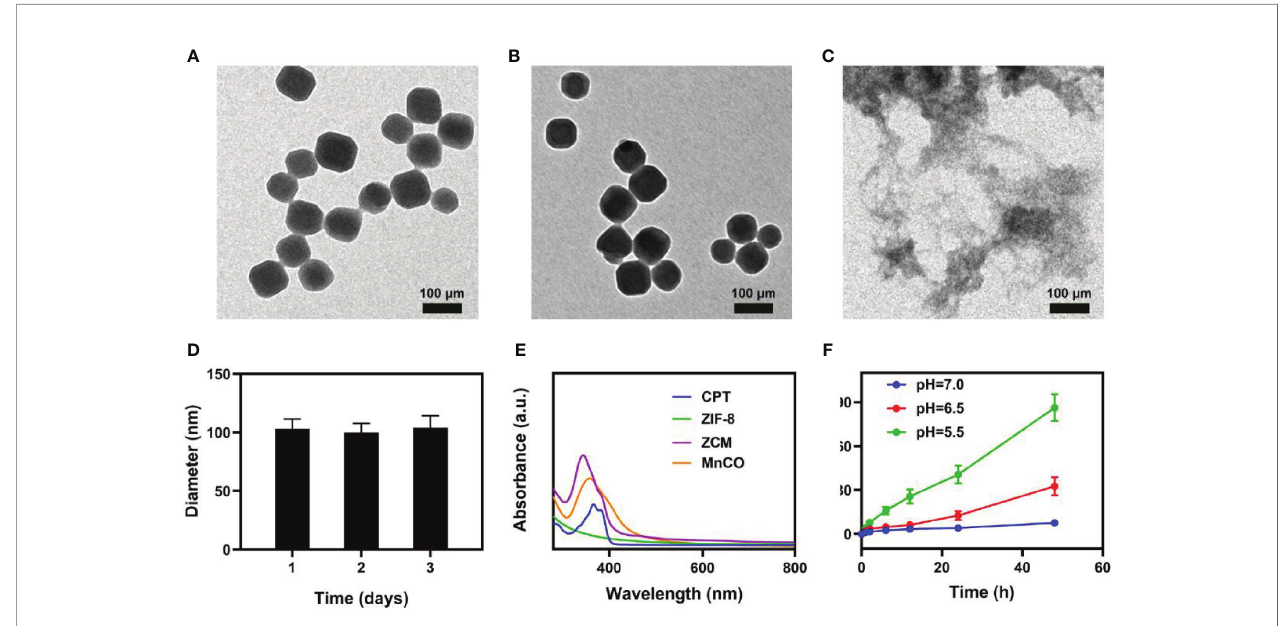
FIGURE 1 | Characterization of ZCM. (A) TEM image of ZIF-8 and (B) ZCM. (C) TEM image of decomposed ZCM. (D) DLS was used to measure the hydrodynamic diameter of ZCM. (E) UV – vis spectra for CPT, ZIF-8, MnCO, and ZCM in PBS. (F) In vitro CPT release pro fi le at different pH from